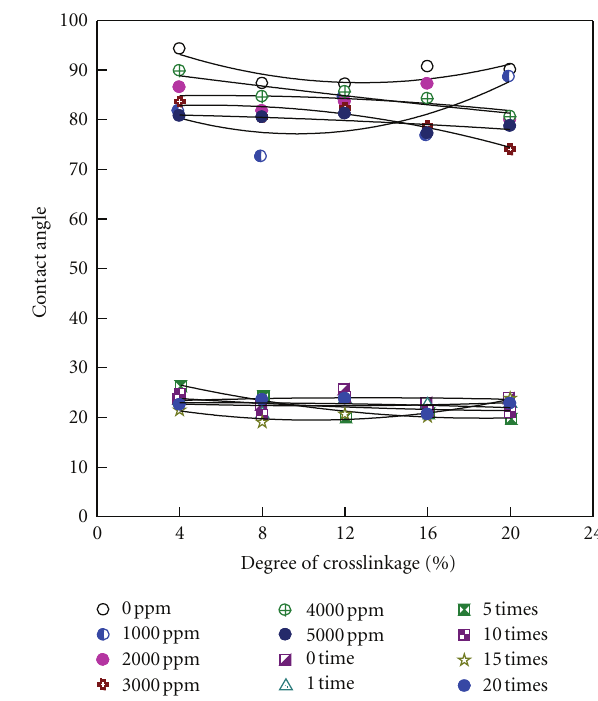
Figure 6: Contact angles of laboratory-produced base membranes with di ff erent degrees of crosslinkage with di ff erent concentrations of phenol and molar ratios of allylbromide to